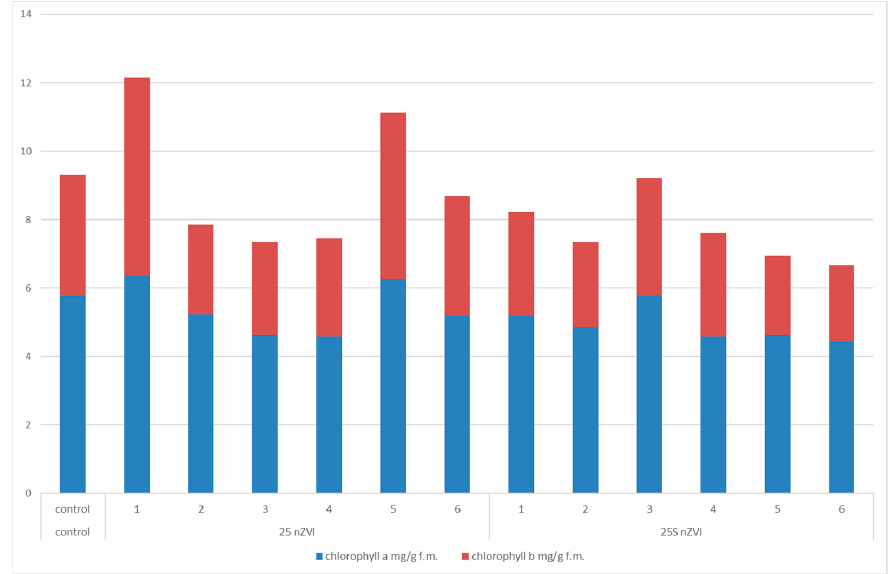
Figure 5. The content of chlorophyll a and chlorophyll b in the shoots of plants grown in soil contaminated with 25 and 25S nZVI. The numbers 1–6 correspond to the following concentrations: 0.5; 1; 5; 10; 50 and 100 g nZVI/kg soil. Vertical bars represents the mean values (n = 5) ± standard deviations.